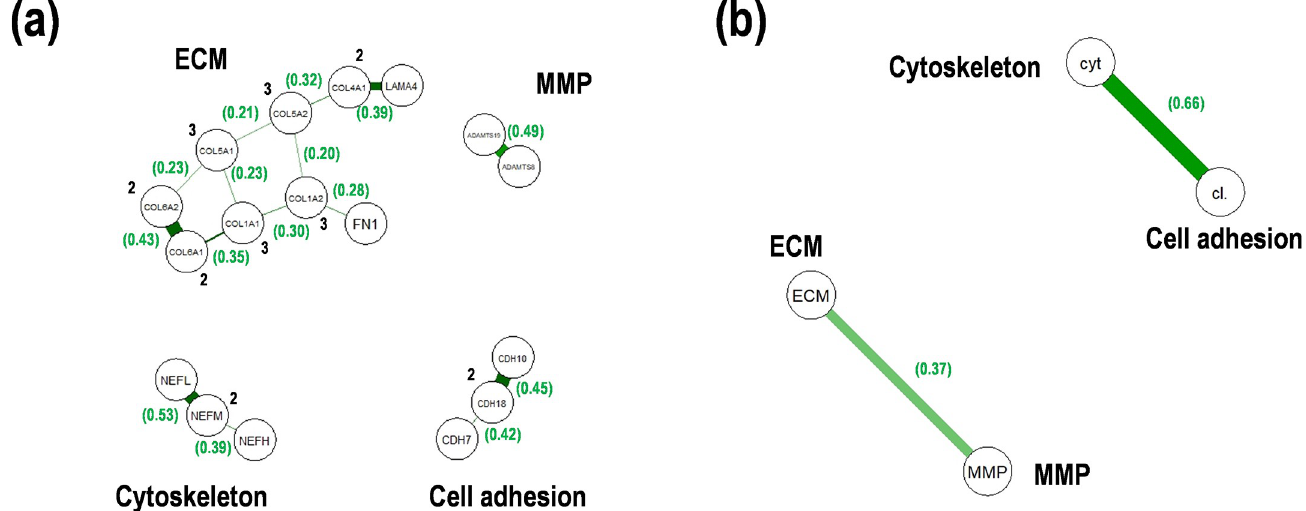
Fig 4. Gene correlations with graphical lasso model in PCNSL. ( a ) Score correlations within each status including cytoskeleton, cell adhesion, extracellular matrix (ECM), and matrix metalloprotease (MMP). ( b ) Score correlations among the statuses. Numbers in the parentheses indicated the edge weights of the nodes.